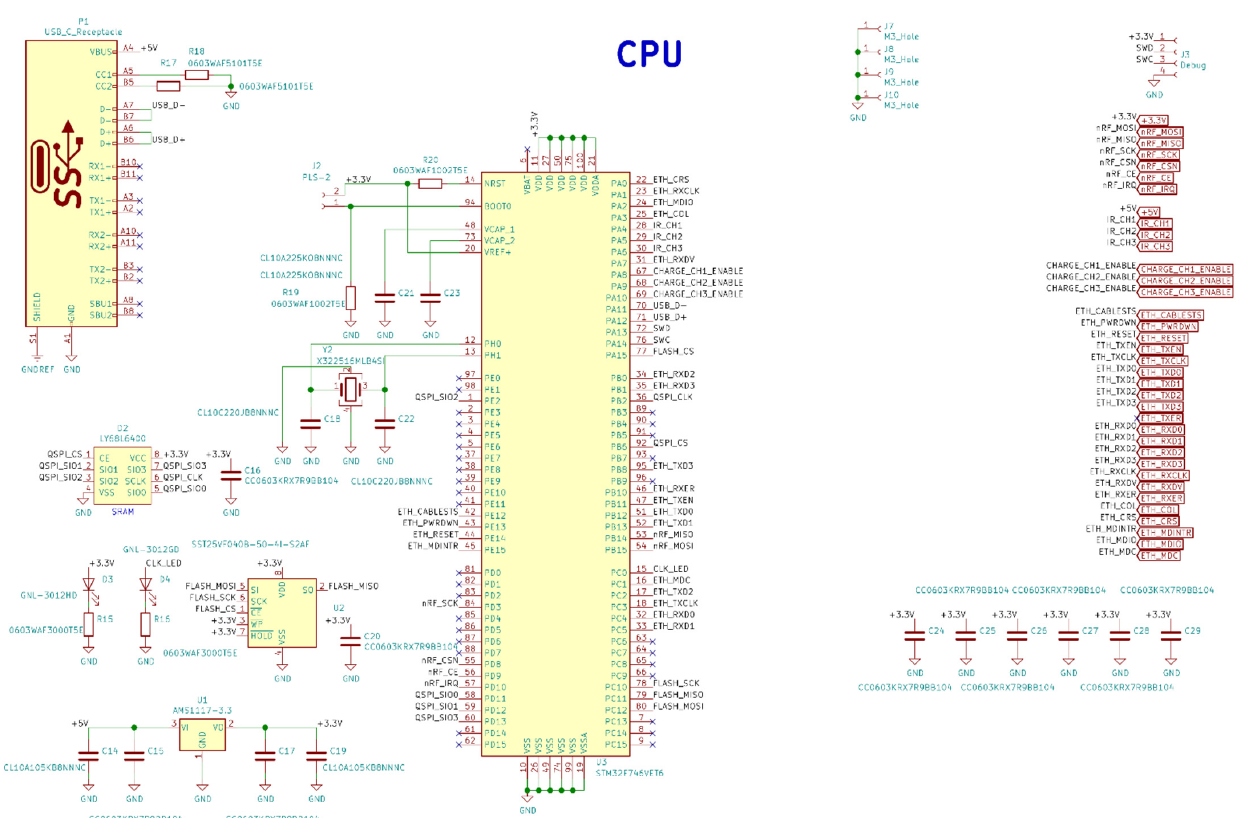
Figure A5. Electrical schematic diagrams of the base station microcontroller and USB Type-C.